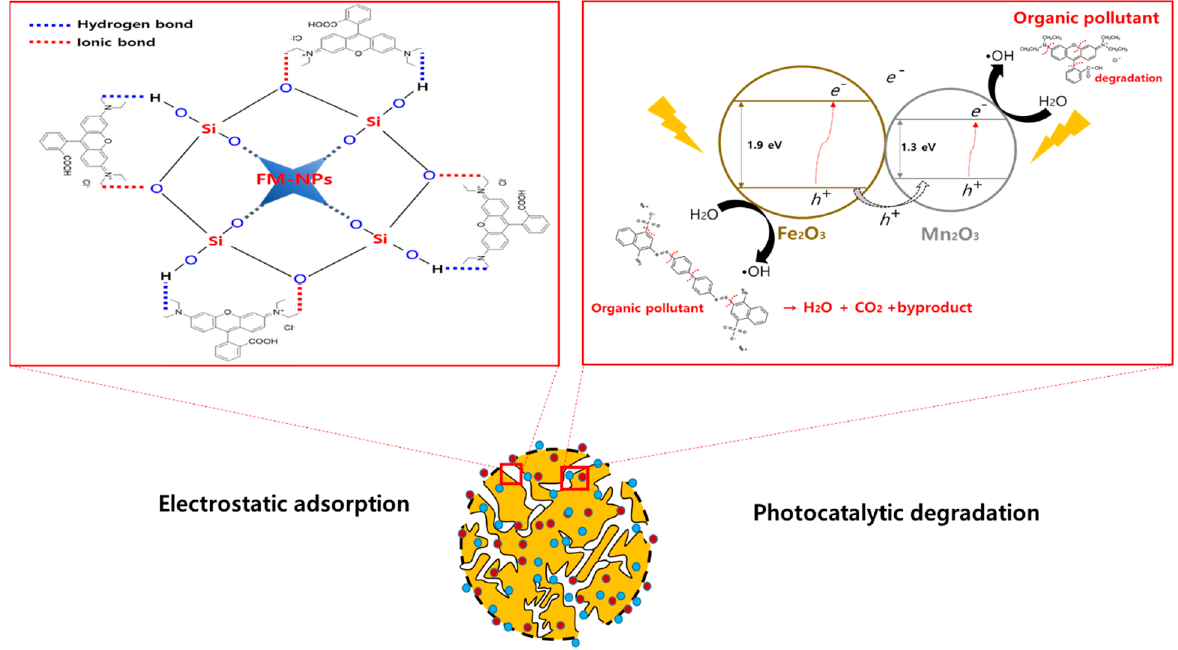
Figure 10. Schematic diagram of the degradation process of the RhB dye by the photocatalytic reaction of FMS.